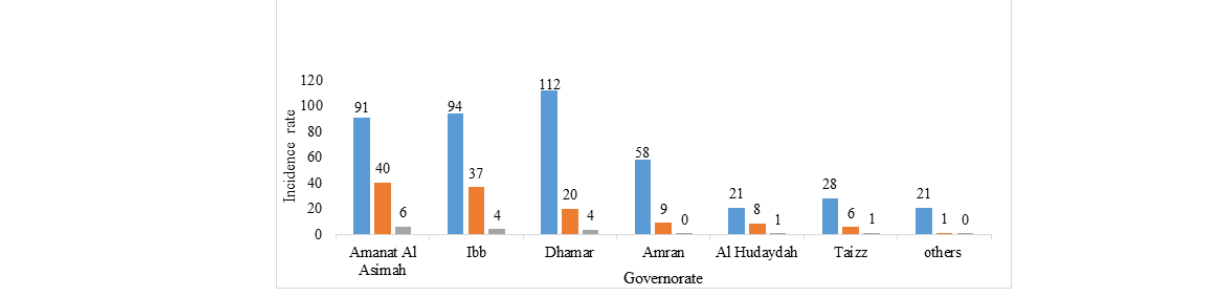
Figure 3. Incidence rate of animal bites, rabies exposed cases, and mortality rate by governorates in Yemen from 2011 to 2017. Blue bars: animal bites/100,000; orange bars: exposed cases/100,000; gray bars: